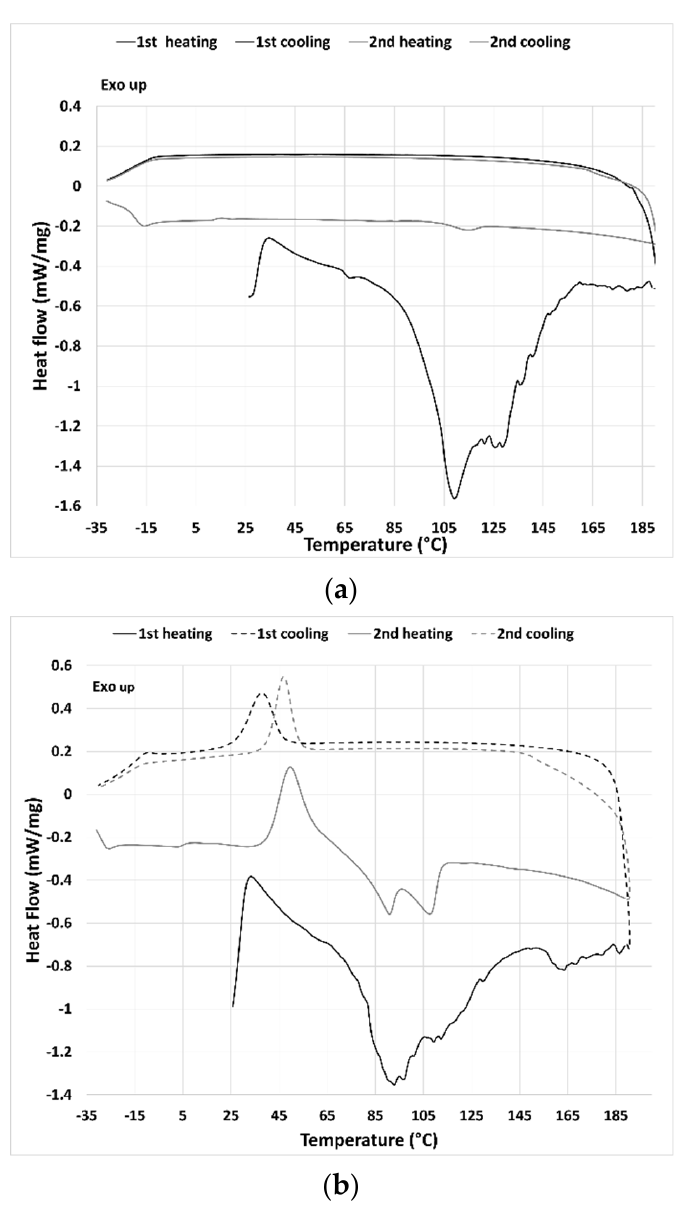
Figure 3. DSC thermograms from cooling/heating cycles from ( a ) CLP − THELES and ( b ) TLB— THELES.